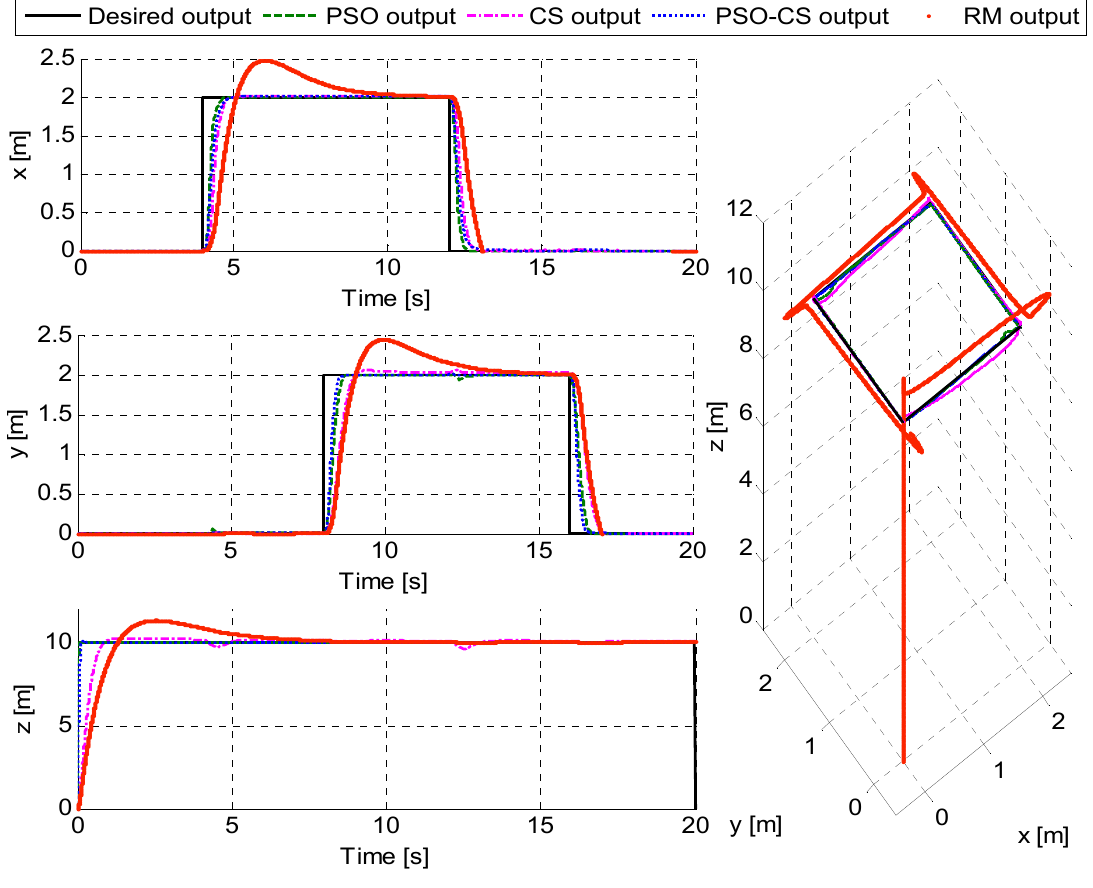
Figure 9. Quadrotor’s positions ( x , y , z ) using Particle Swarm Optimization (PSO), Cuckoo Search (CS), Particle Swarm Optimization-Cuckoo Search (PSO-CS), and Reference Model (RM) (rectangular trajectory).